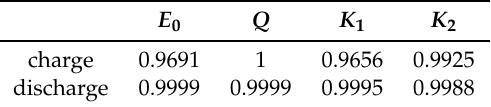
Table 8. Goodness of curve fitting characterized by the r 2